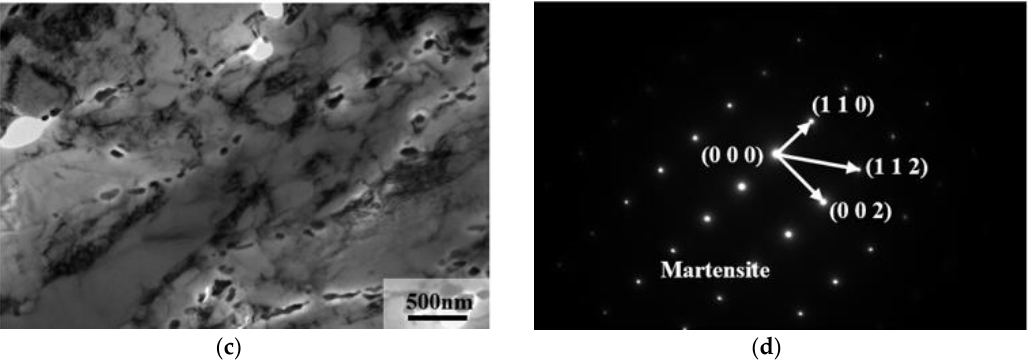
Figure 11. Transmission electron microscopy (TEM) image of heat-resistant steel after heat treatment: ( a ) and ( b ) 9Cr–1.5Mo–1Co, ( c ) and ( d ) 9Cr–3W–3Co. TEM images of precipitated phases in 9Cr–1.5Mo–1Co and 9Cr–3W–3Co heat-resistant steel are